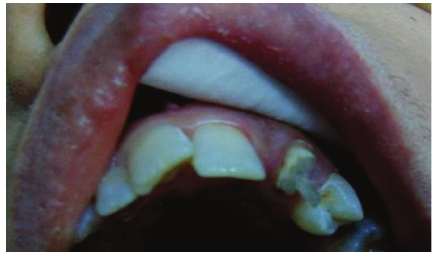
Figure 2: Fabrication of individual fiber post to the canine.